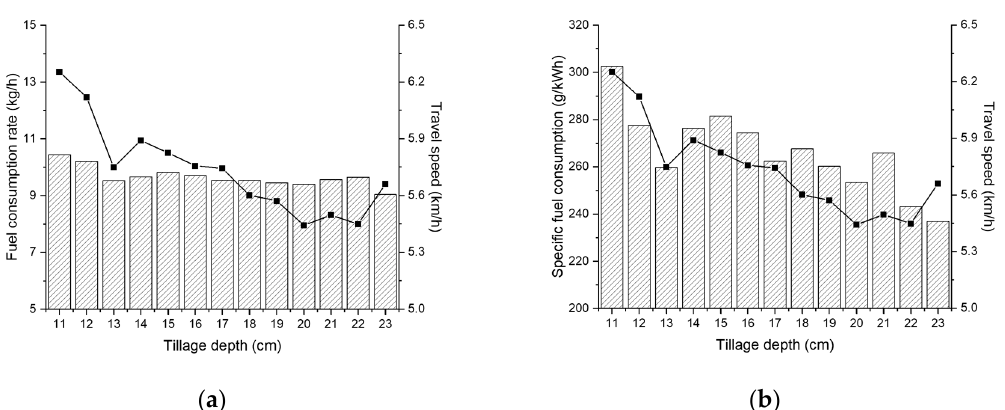
Table 8. Descriptive statistics of specific fuel consumption (g/kWh) according to tillage depth. Tillage Depth